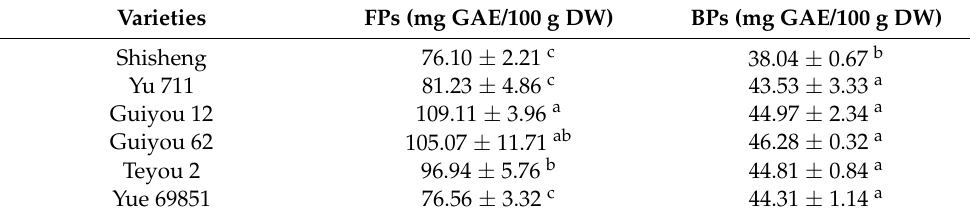
Table 2. Total phenolic content of FPs and BPs in mulberry seeds.